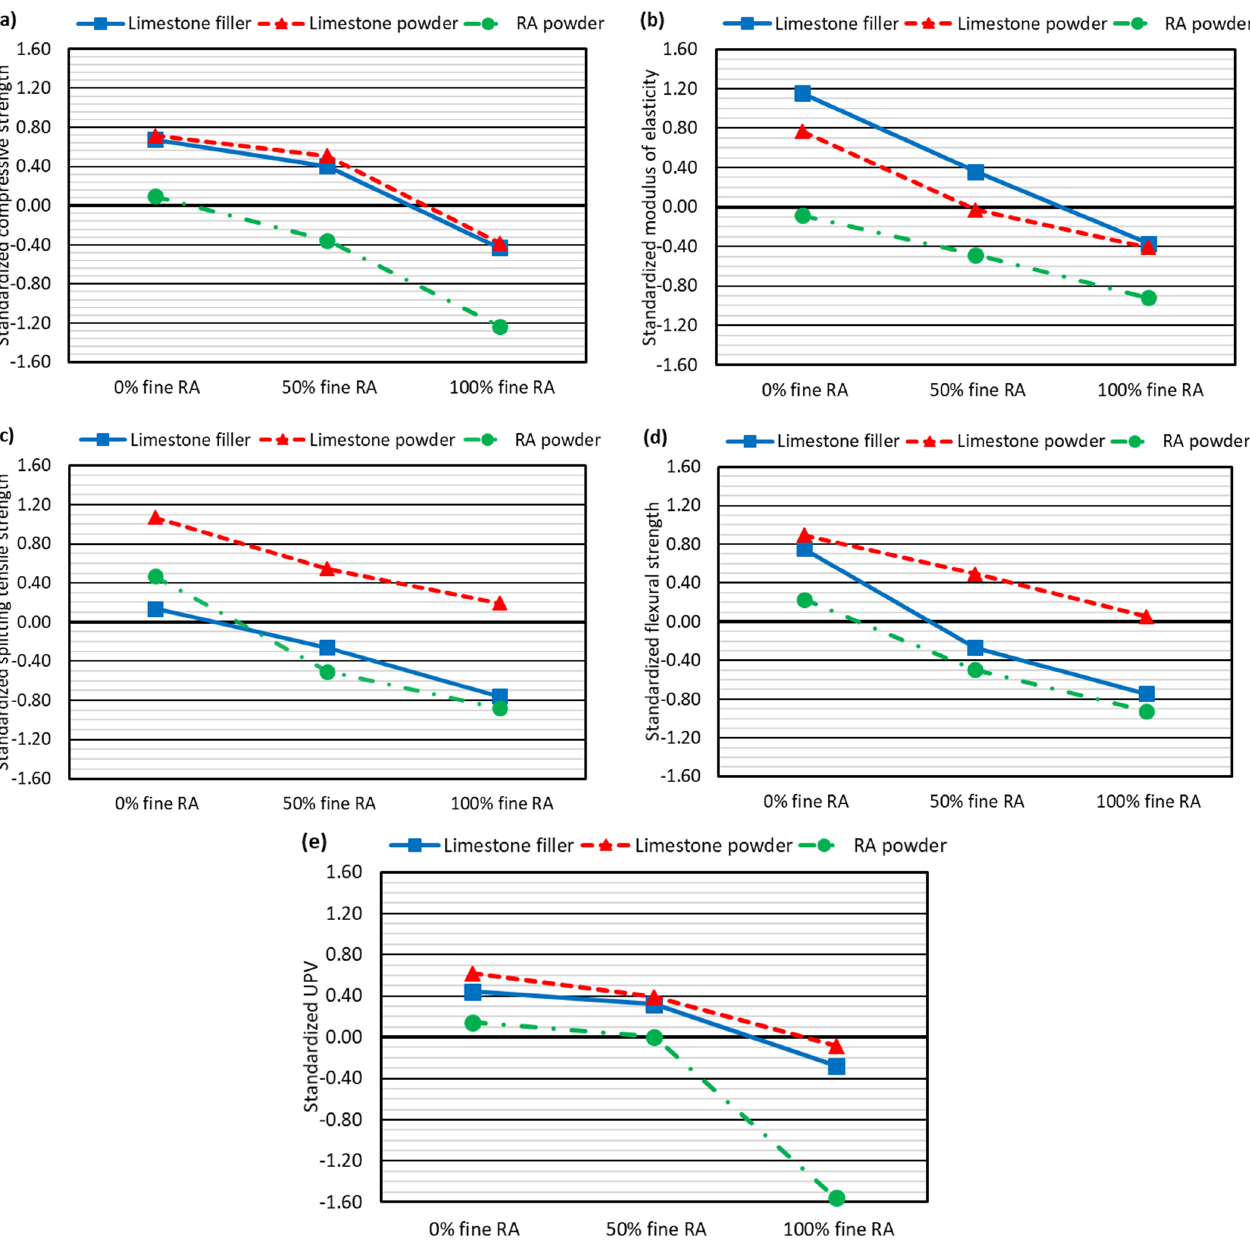
Figure 7. Standardized properties of SCC mixes: ( a ) compressive strength; ( b ) modulus of elasticity; ( c ) splitting tensile strength; ( d ) flexural strength; ( e ) UPV.